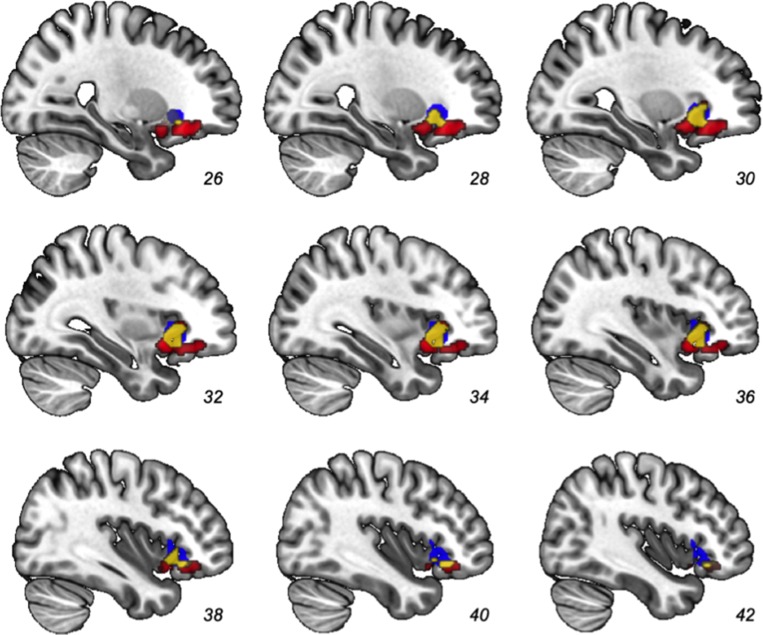
Overlap between latent structure model parametric modulator and a separately derived ROI.Overlap (yellow) between our latent structure model result (red) and a separately derived ROI of cluster structure updating (blue; Tomov et al., 2018).